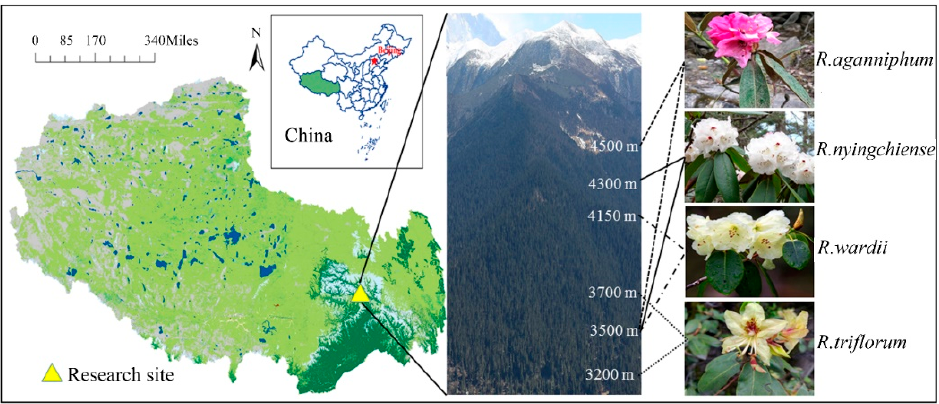
Figure 1. Research site and distribution of four Rhododendrons on Sygera mountain. The white numbers on the mountain indicate the elevation.